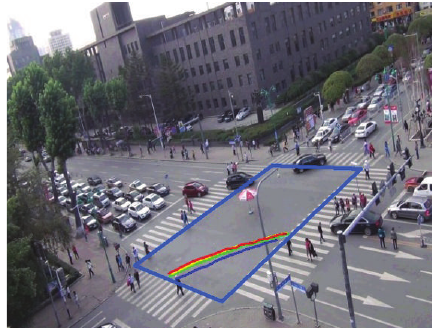
Figure 2: Extraction of left-turning vehicles’ trajectories schematic